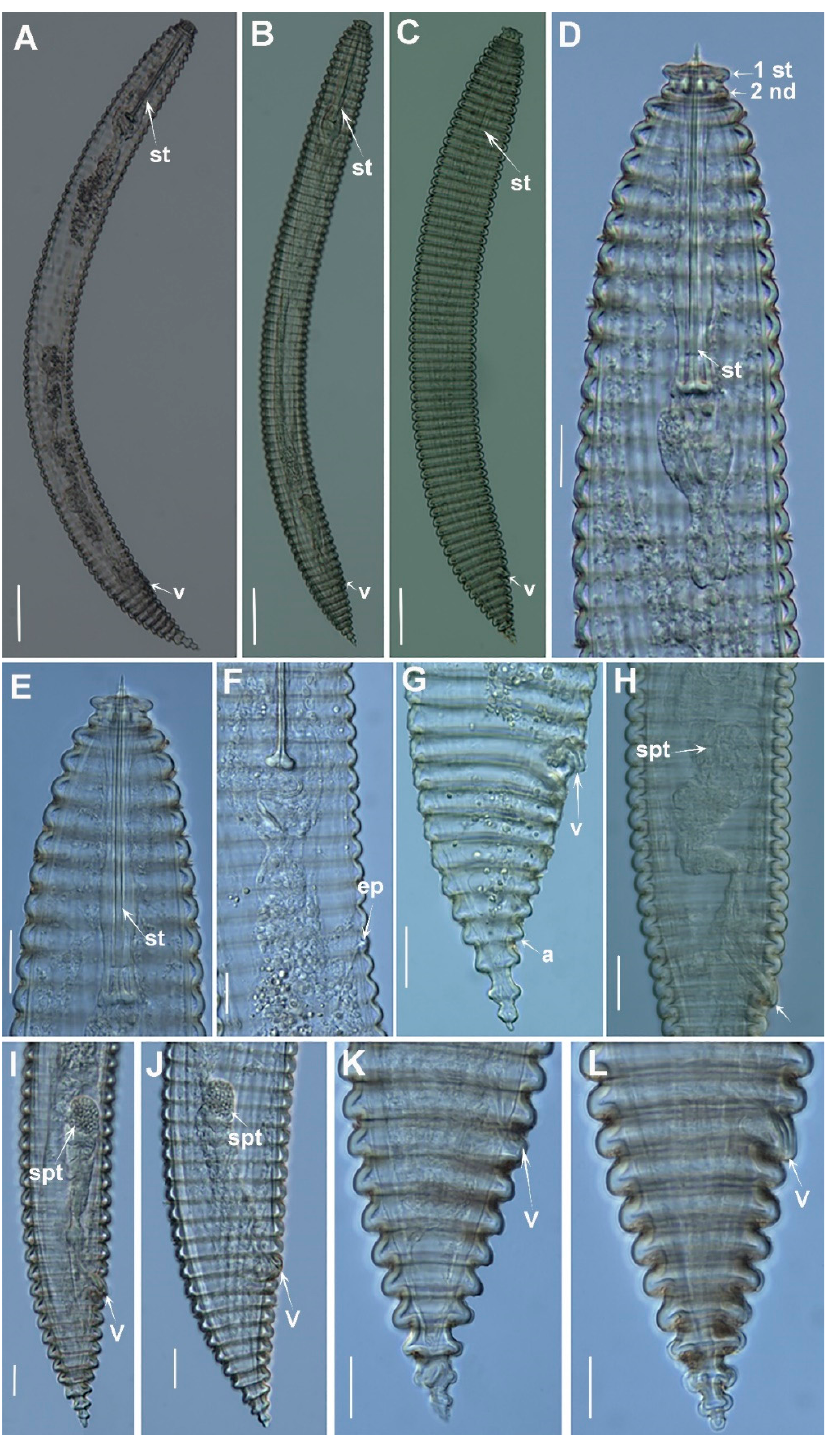
Figure 4. Light micrographs of Criconema pseudoannuliferum sp. nov. females. ( A – C ), whole female; ( D ), female pharyngeal region 1st and 2nd body annuli (arrowed); ( E , F ) female anterior region showing excretory pore; ( G – L ), female posterior region showing spermatheca filled with sperm (arrowed). Abbreviations: ep = excretory pore; spt = spermatheca, st = stylet; V = vulva; 1st, 2nd = first- and second-body annuli. Scale bars: ( A – C ) = 50 µm; ( D – L ) = 20 µm.